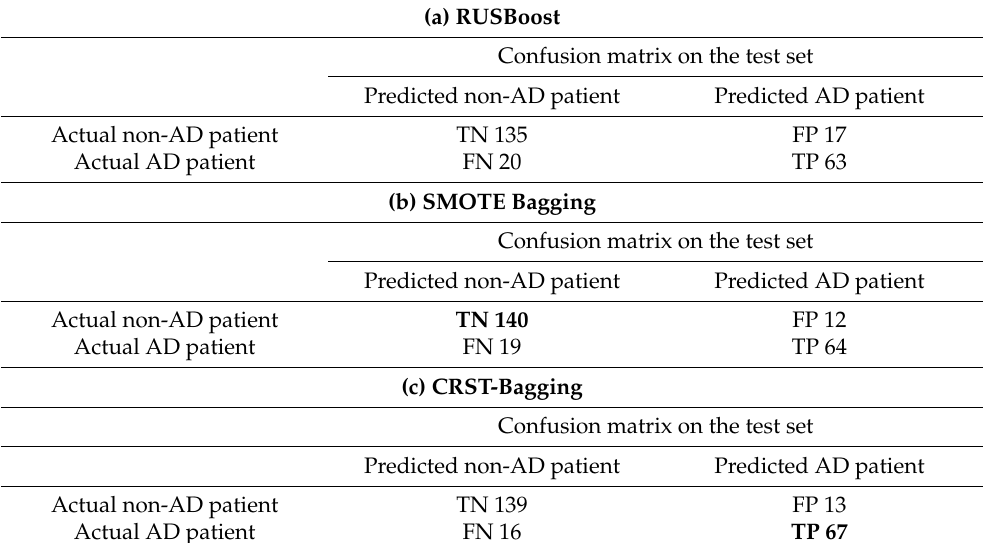
Table 5. Confusion matrix of RUSBoost ( a ), SMOTEBagging ( b ), CRST-Bagging ( c ) on the test